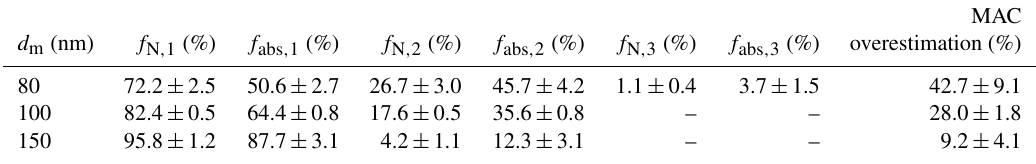
Table 3. Number concentration fractions and absorption contributions for different size fresh soot particles with single, double or triple charges and the overestimation of MAC